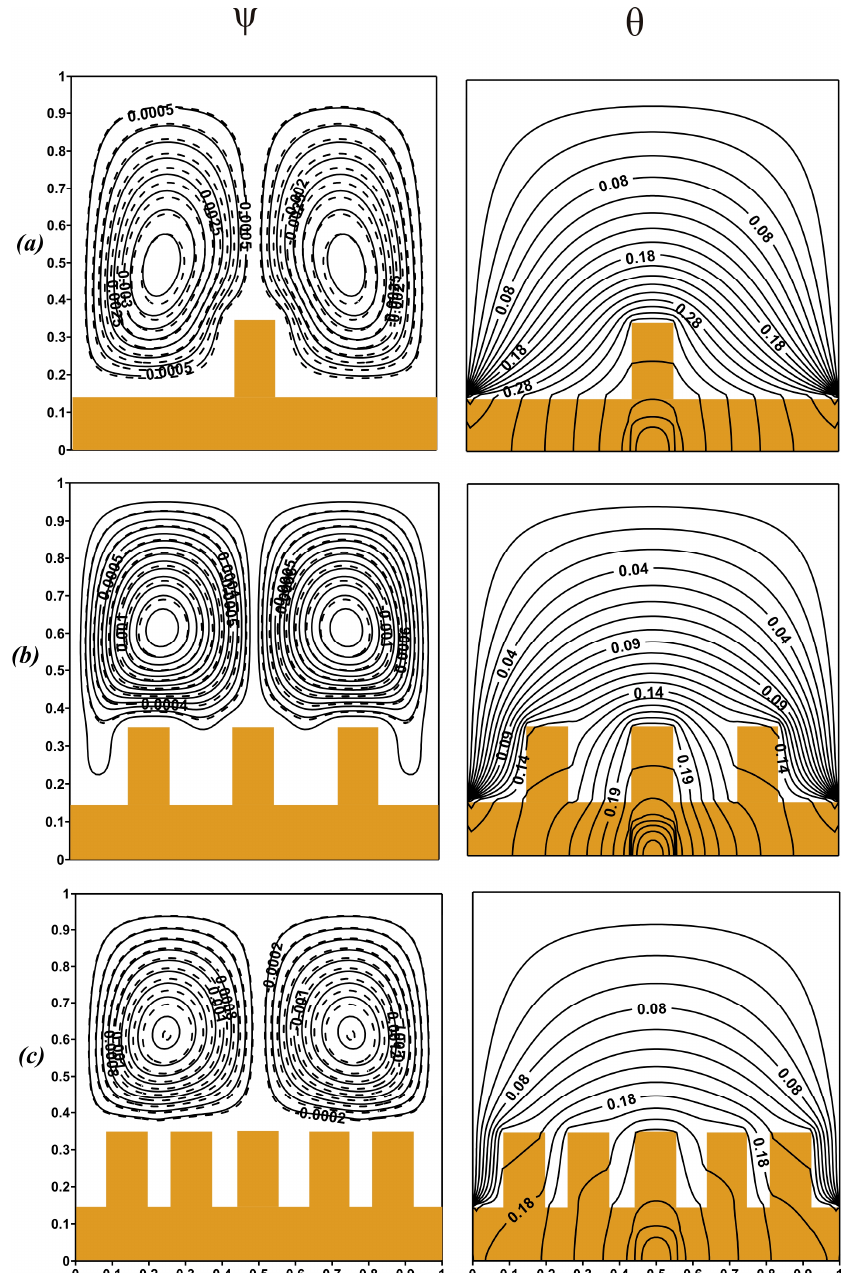
Figure 6. Isolines of ψ and θ for h 1 = 0.15, ζ = 0 (solid lines), ζ = 1 (dashed lines): ( a ) n = 1; ( b ) n = 3; ( c ) n = 5.